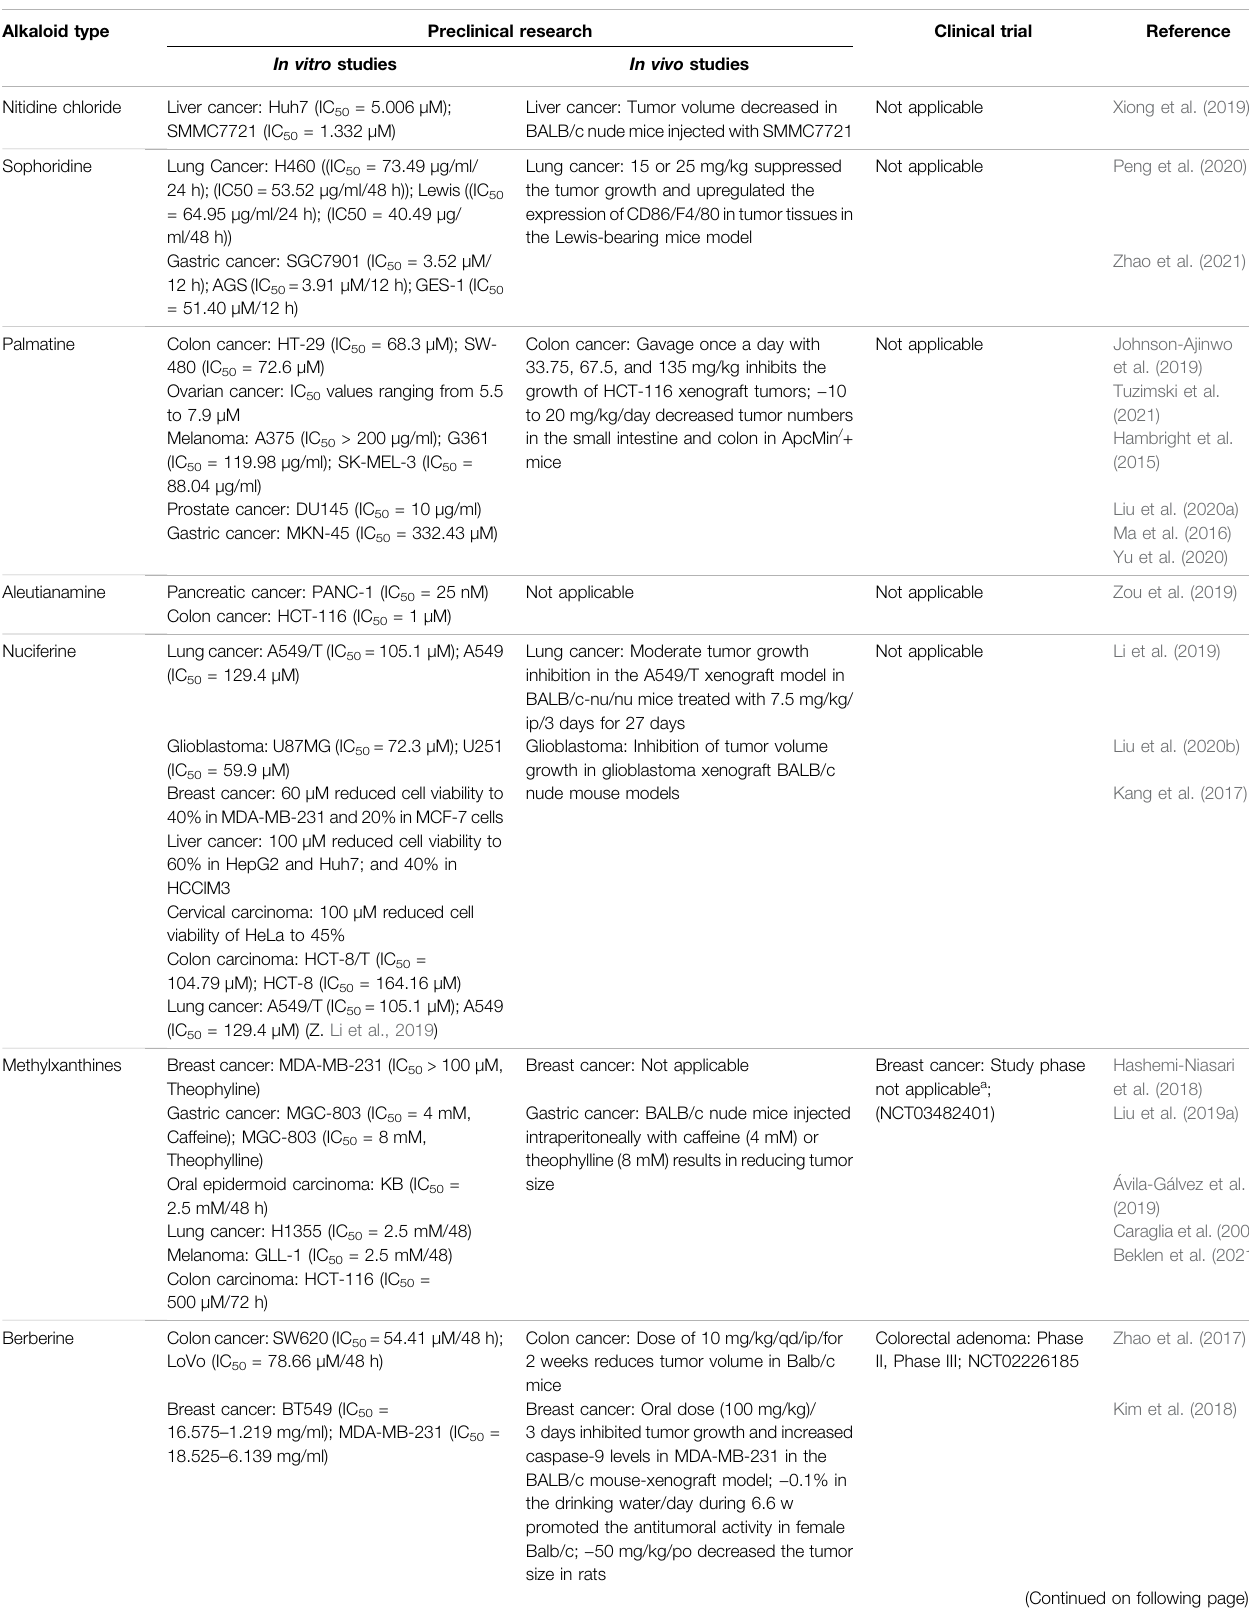
TABLE 2 | Summary of recent preclinical and clinical trials of plant-based alkaloids on cancer treatment. Alkaloid